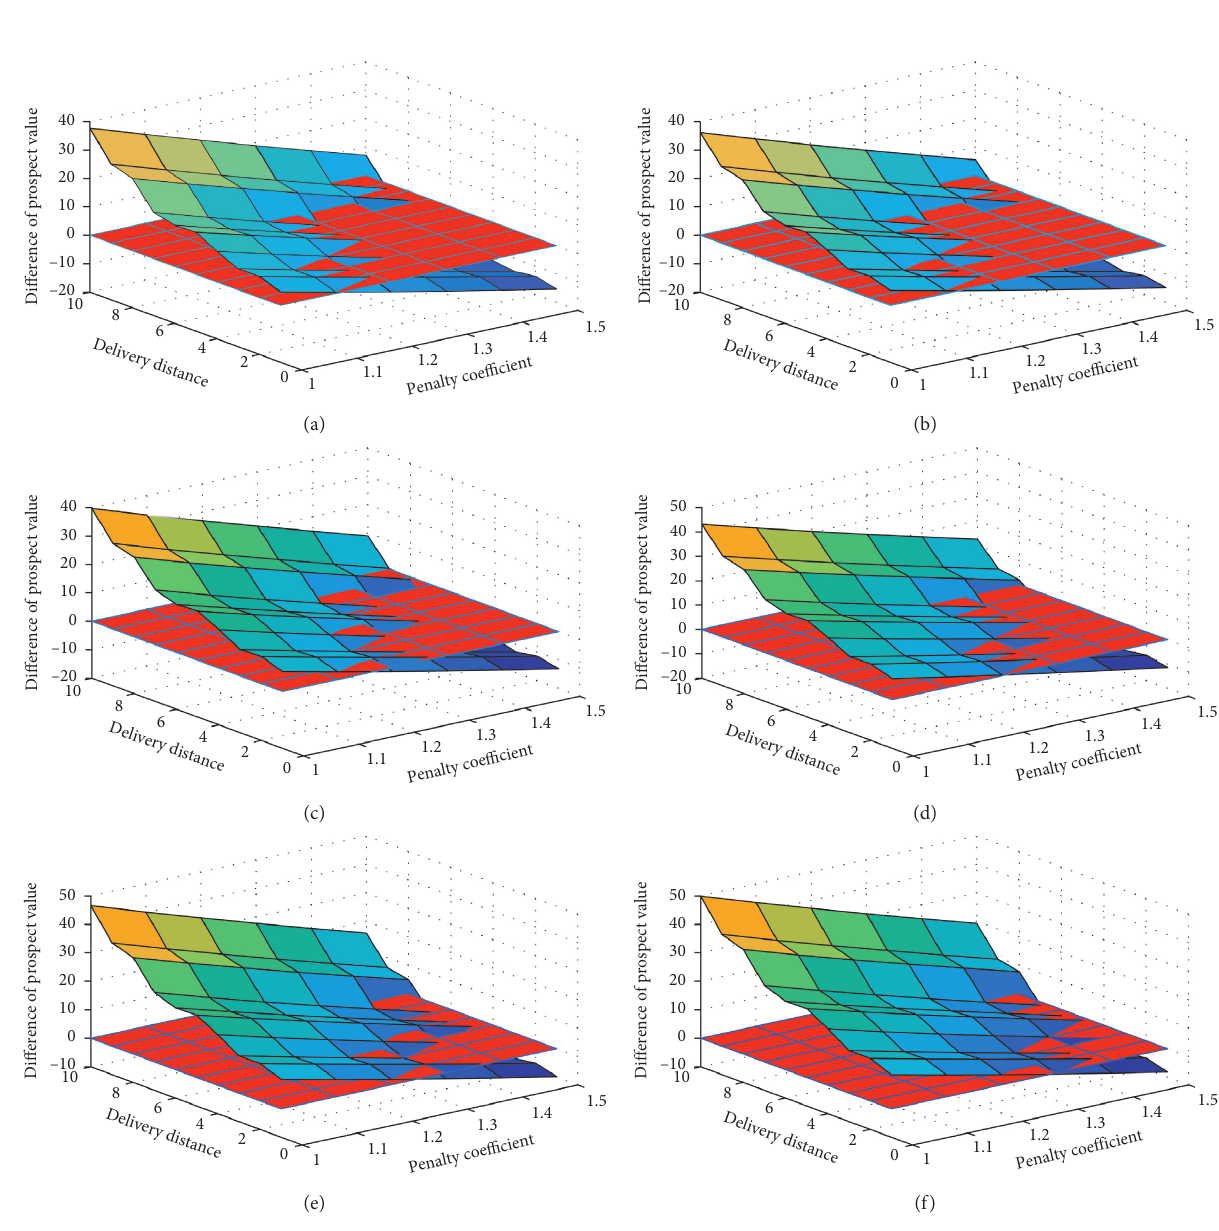
Figure 4: Difference of prospect value between drone delivery and rider delivery under different delay coefficients. (a) Difference of prospect value when t � 5 and c � 1; (b) difference of prospect value when t � 5 and c � 1.1; (c) difference of prospect value when t � 5 and c � 1.2; (d) difference of prospect value when t � 5 and c � 1.3; (e) difference of prospect value when t � 5 and c � 1.4, (f) difference of prospect value when t � 5 and c �